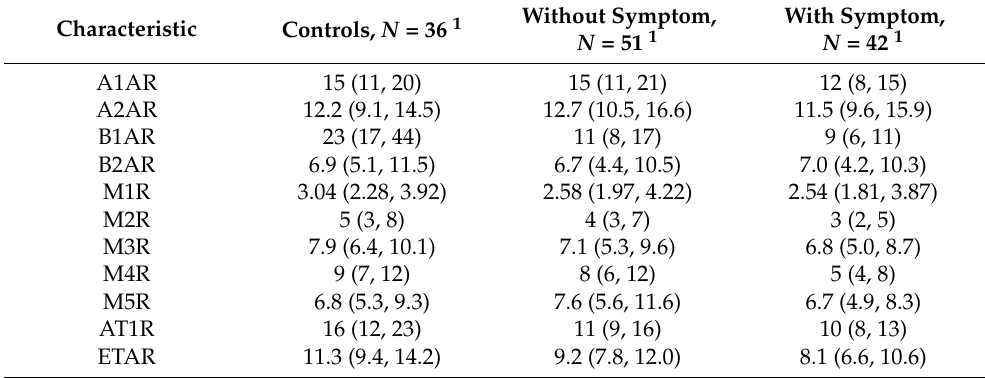
Figure 2. Autoantibodies against autonomic nervous system receptors are correlated with sleep disturbance in symptomatic women with SBIs. Individual measurements are shown as dots, summary data as box plots, and the distributions as violin plots. Green dots: healthy controls; Blue dots: silicone-breast-implant patients without clinical manifestations; red dots: silicone-breast-implant patients with clinical manifestations. Table 3. Cognitive